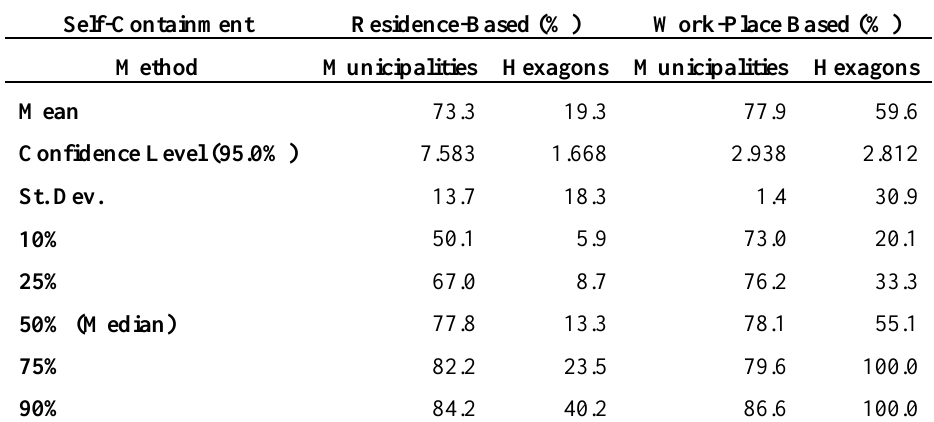
Table 4. Residence-based and workplace-based self-containment in municipalities and hexagons.